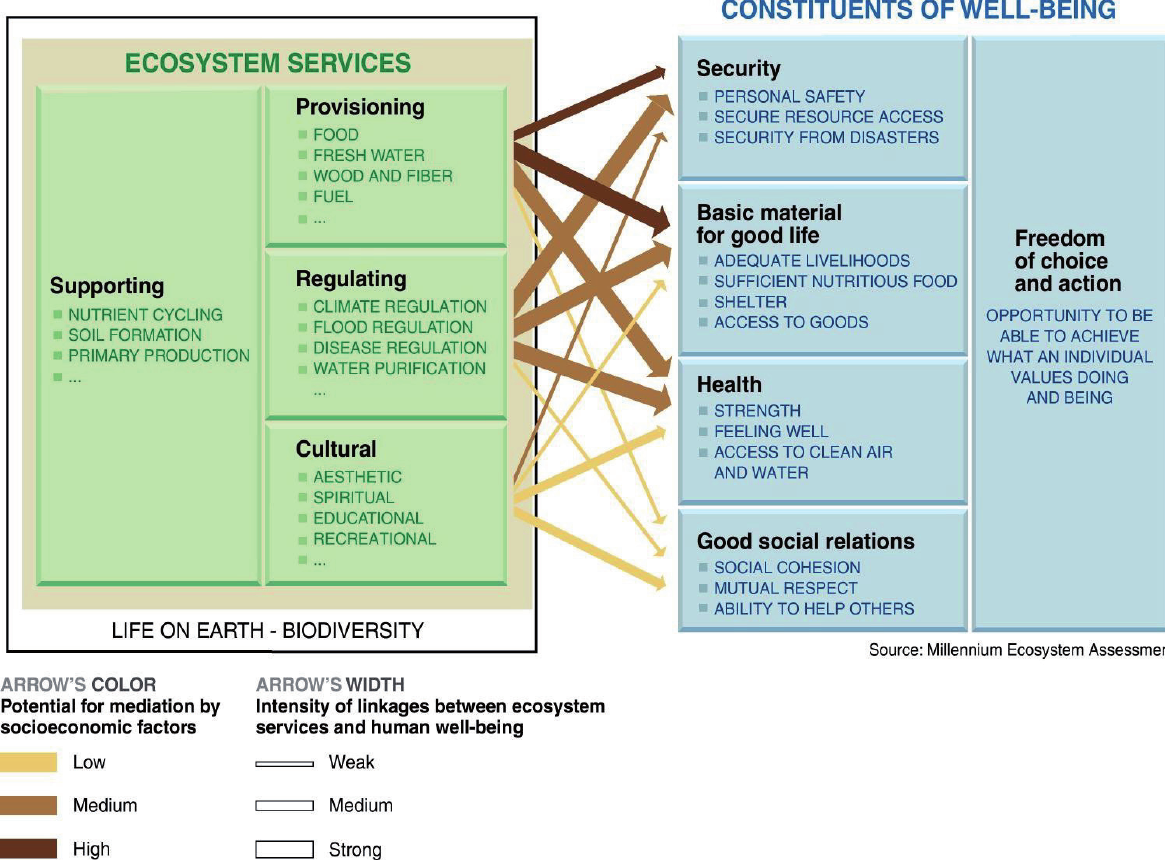
Figure 1. The Framework of the Millennium Ecosystem Assessment (2002). Reproduced from the Millenium Ecosystem Assessment (2002).